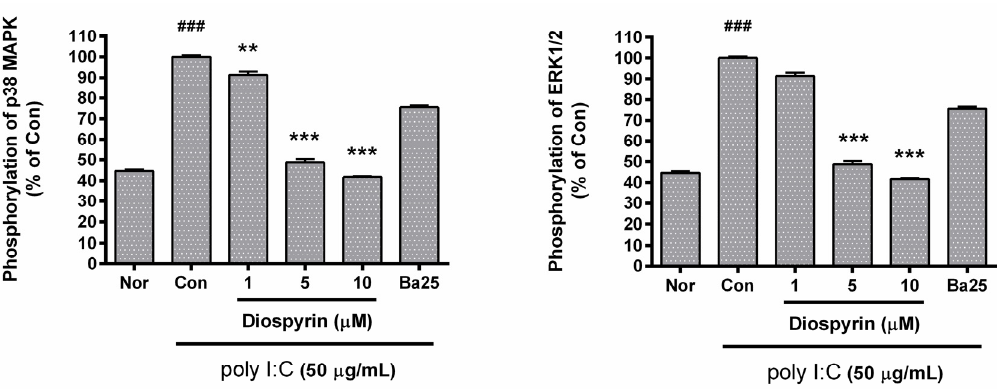
Figure 5. The phosphorylation of p38 MAPK and ERK 1 / 2 in RAW 264.7. Values are the mean ± SD of the three independent experiments. Nor, media alone; Ba25, Baicalein (25 µ M). ### p < 0.001 vs. Nor. ** p < 0.01 vs. Con; *** p < 0.001 vs. Con.